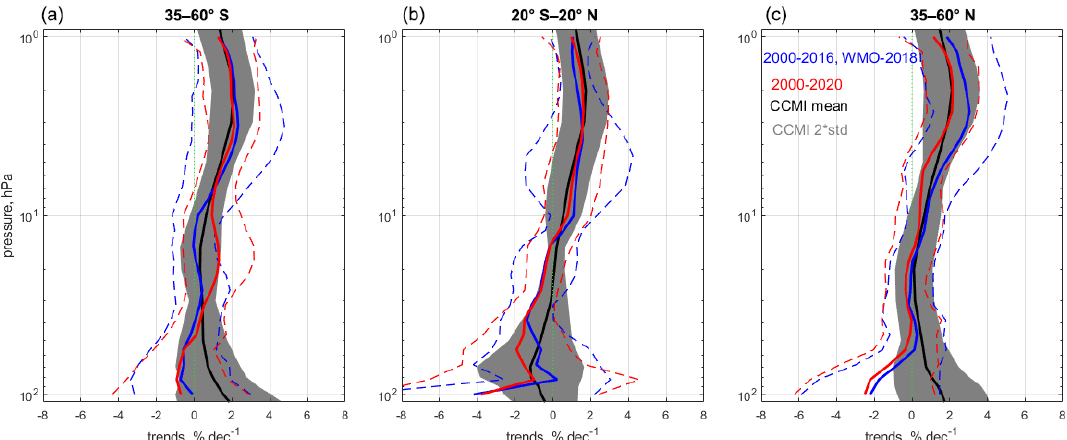
Figure 5. Black line: multi-model mean ozone profile trend estimates from the CCMI-1 REF-C2 simulations over three broad latitude bands red (light blue) dashed lines represent LOTUS22 (LOTUS19) average and 2 σ uncertainty